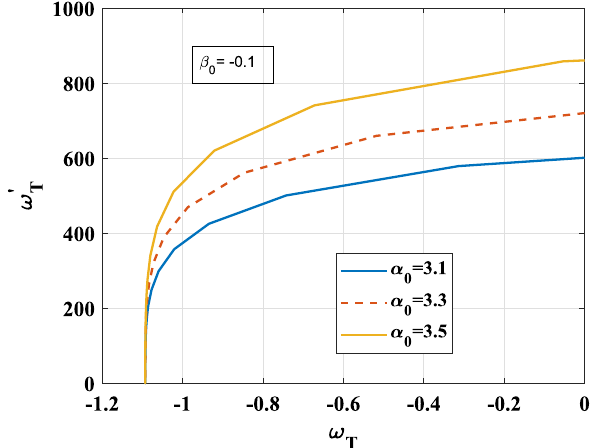
for k = 1 . 9, α 1 = 1 . 2, α 2 = 0 . 52, T